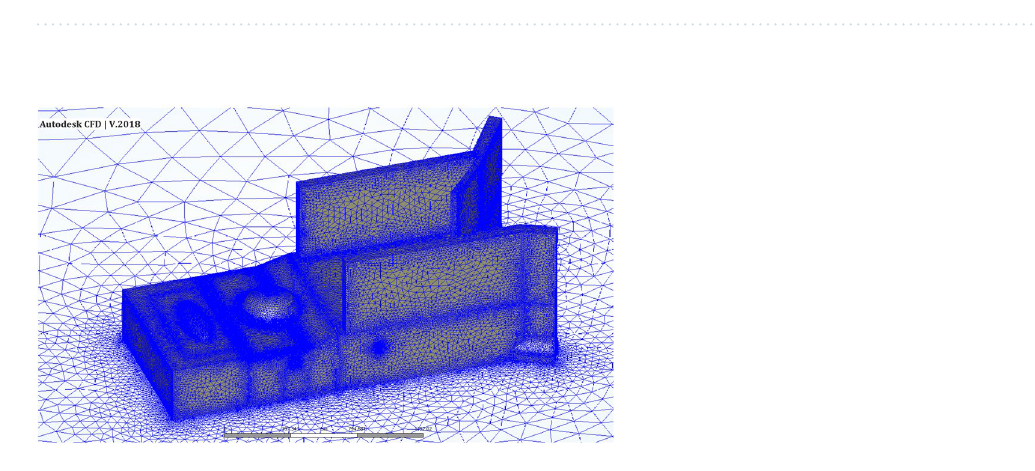
Figure 9. Schematic view of the CFD